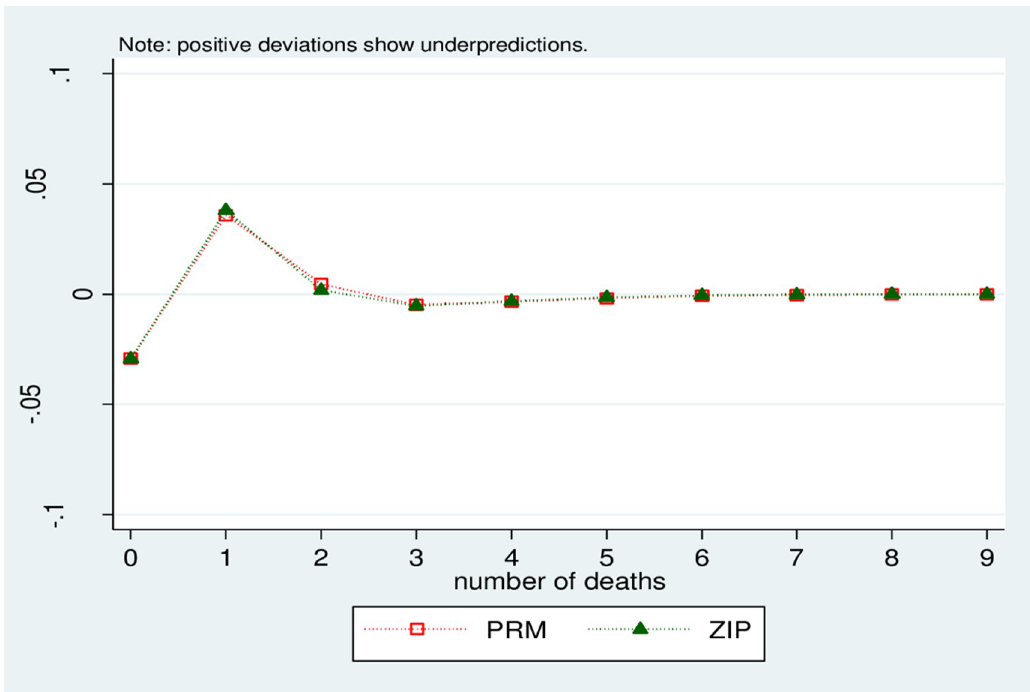
Fig 3. Difference between observed and predicted proportions for number of under five deaths per